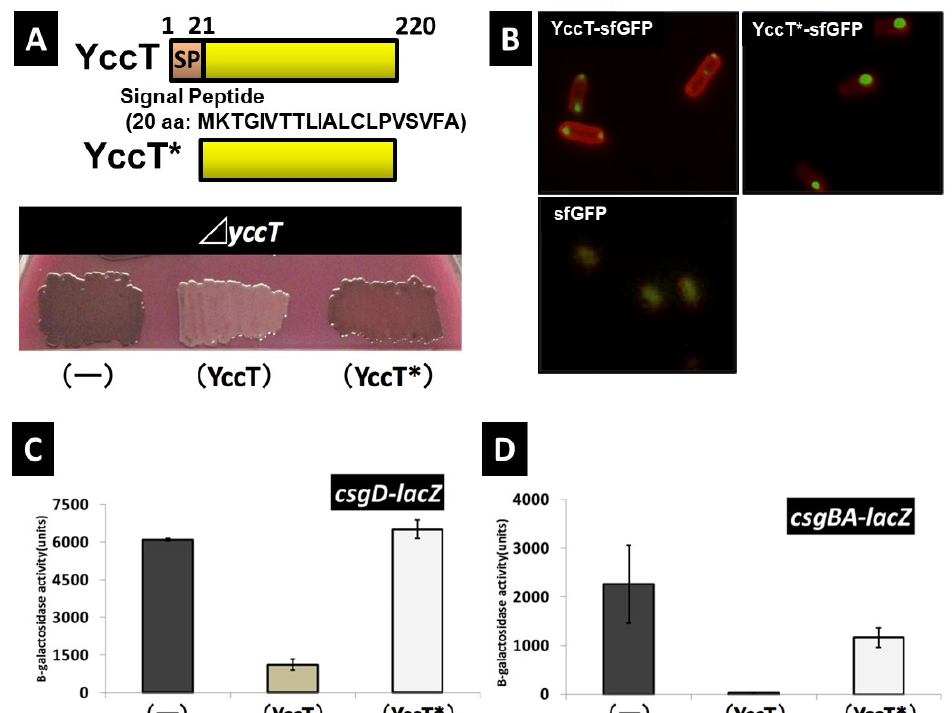
Figure 6. Effects of the deletion of YccT signal peptide on the curli fimbriae formation, YccT localization, and the expression of curli genes. ( A ) Curli fimbriae formation was assessed by Congo red staining. YccT* has a deletion of the signal peptide (first 20 N-terminal amino acids) (upper figure). The yccT deletion strain ( ∆ yccT ) was transformed with the control pBAD18 ( − ), pBADyccT (YccT), or pBADyccT* (YccT*) vector. Cells were plated and incubated on a Congo red YESCA plate in the presence of arabinose (final concentration 0.2%) at 28 ◦ C for 2 days. ( B ) Localization of YccT-sfGFP and YccT*-sfGFP in the wild-type strain (WT). The expression of sfGFP was used as negative control. The membranes of the E.coli cells were stained with FM4-64 (red). ( C ) The csgD promoter activity was determined by ß-galactosidase activity assay using a single copy csgD promoter- lacZ fusion ( csgD-lacZ ) in the WT containing the control pBAD18 ( − ), pBADyccT (YccT), or pBADyccT* (YccT*) vector. The cells were cultured in the presence of arabinose (final concentration 0.2%) at 28 ◦ C for 16 h. ( D ) The csgB promoter activity was determined by ß-galactosidase activity using a single copy csgB promoter- lacZ fusion ( csgBA-lacZ ) in the WT containing the control pBAD18 ( − ), pBADyccT (YccT), or pBADyccT* (YccT*) vector. The cells were cultured in the presence of arabinose (final concentration 0.2%) at 28 ◦ C for 16 h. The activity values represent the means ± SEs of triplicate